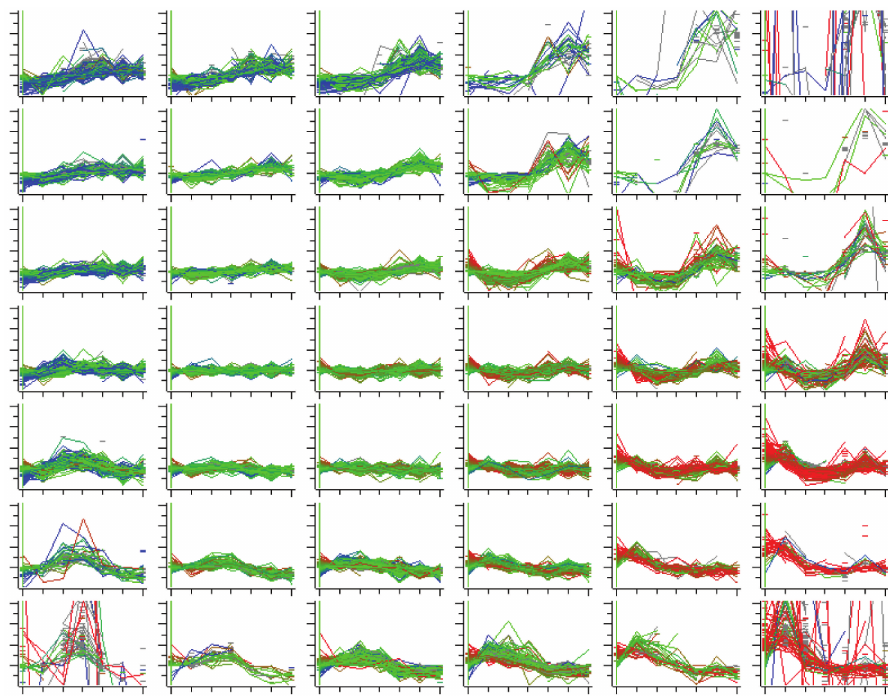
Figure 4: Infectomic profiles of C. neoformans -infected HBEMC using SOM analysis. Gene profiles of HBMEC postinfection at 7 time points (0, 4, 8, 12, 16, 20, 24 hours) ( x -axis) were analyzed by SOM (7 x 6). Upper bound (4.0), normal (1.0), and lower bound (0.0) were shown ( y